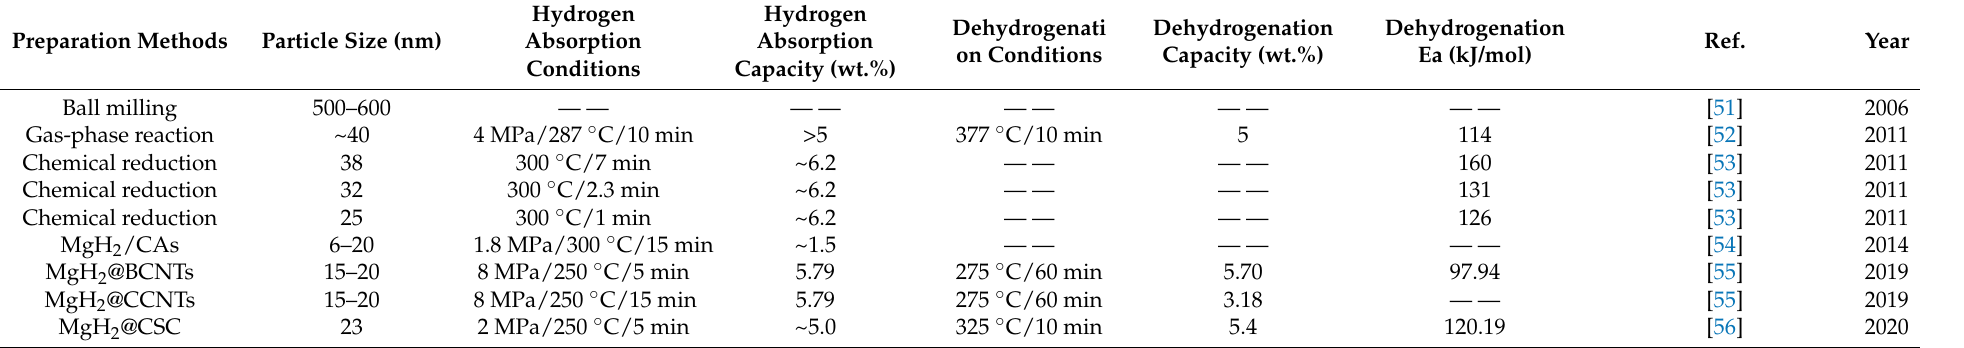
Table 2. Improvement of hydrogen storage performance of Mg/MgH 2 by